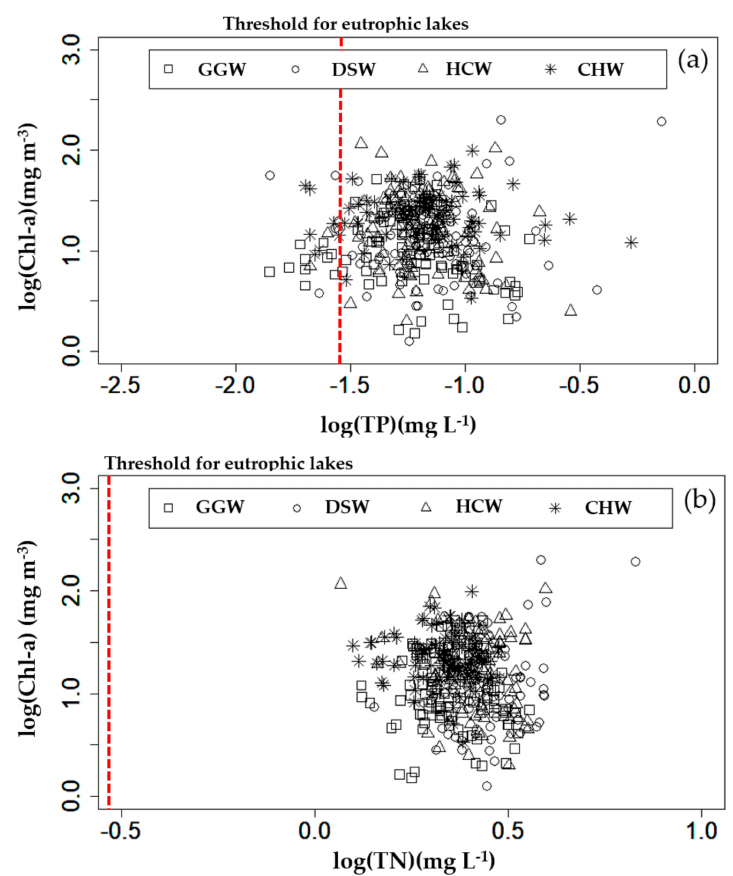
Figure 4. Correlations between; ( a ) Log (Chl–a) (mg m − 3 ) and Log (TP) (mg L − 1 ), and ( b ) Log(Chl–a) (mg m − 3 ) and Log (TN) (mg L − 1 ) at Gangjeong Goryeong weir (GGW), Dalseong weir (DSW), Hapcheon Changnyeong weir (HCW), and Changnyeong Haman weir